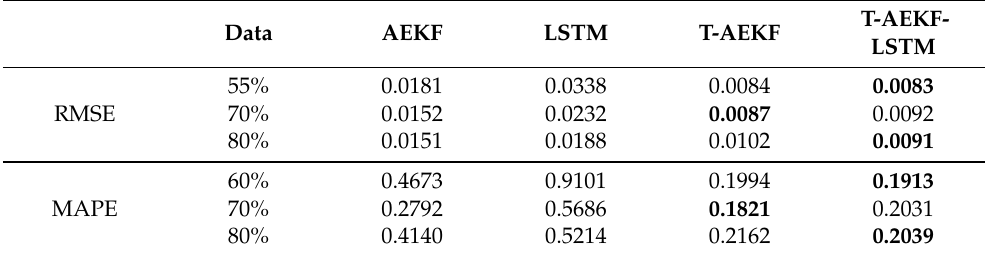
Table 3. The prognostic results for